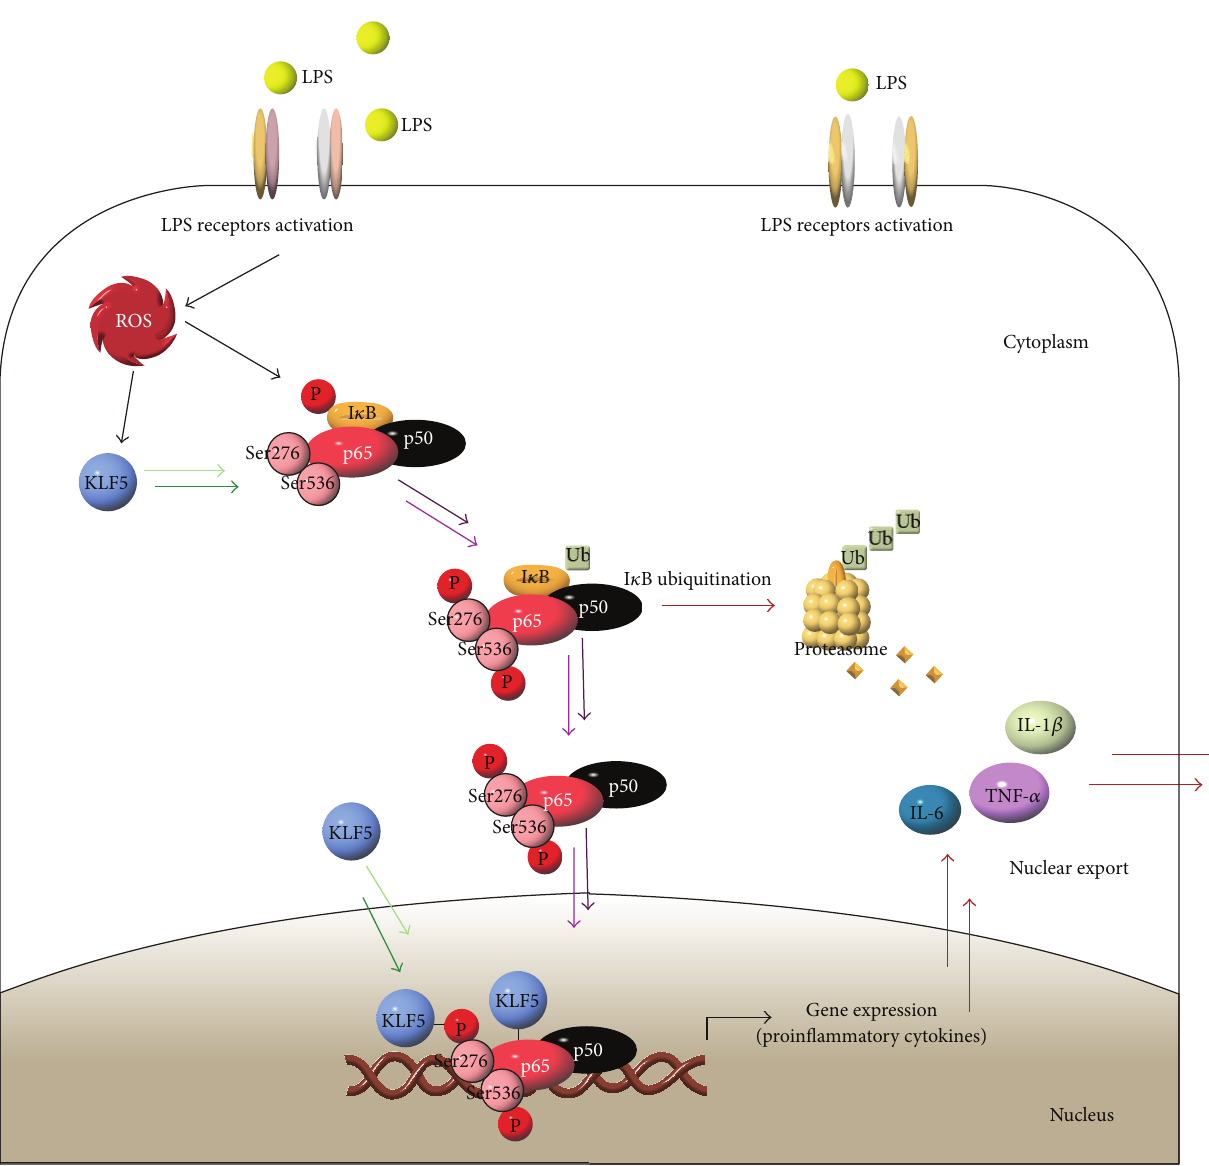
Figure 7: Kr¨uppel-like factor 5 mediation of proinflammatory cytokine expression through upregulation of nuclear factor-kappaB subunit phosphorylation at p65 in response to lipopolysaccharide in human bronchial epithelial